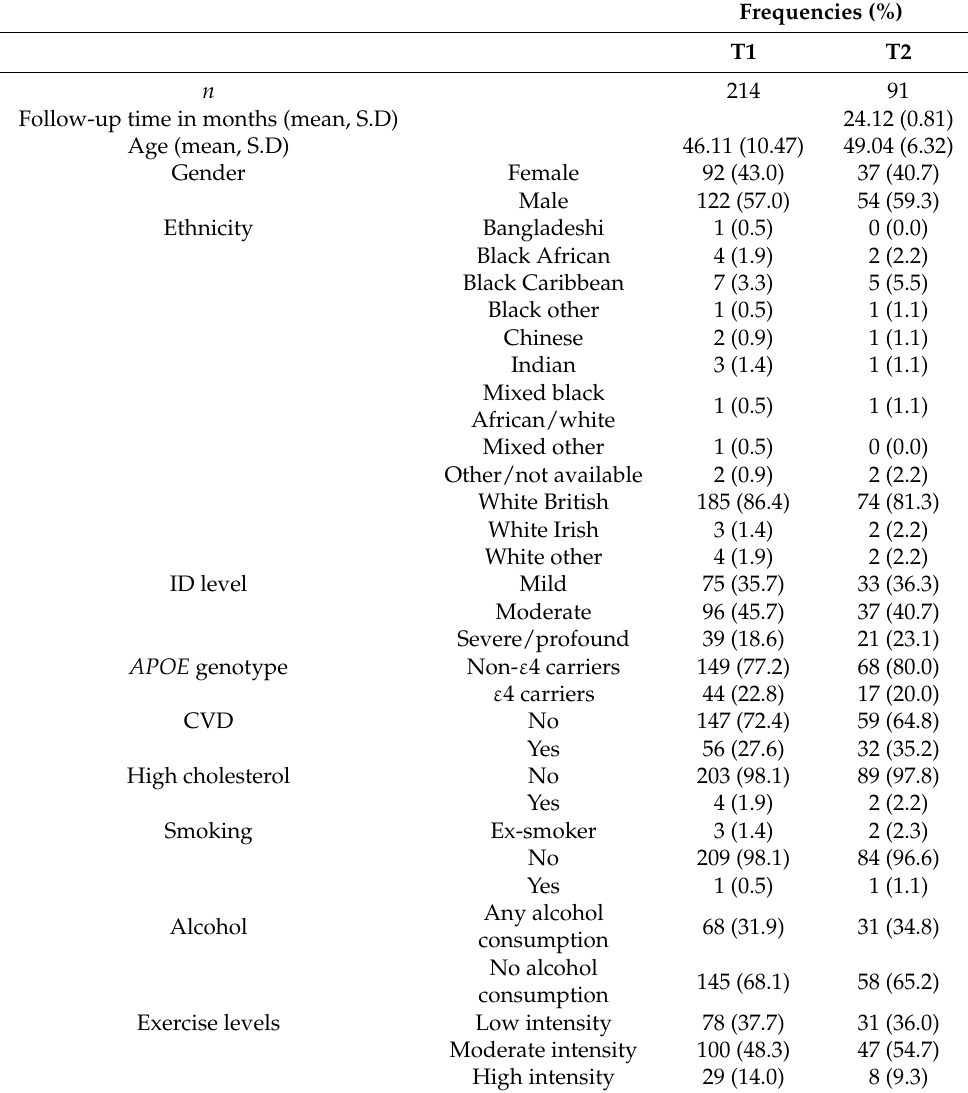
Table 1. Demographics of participants at T1 and